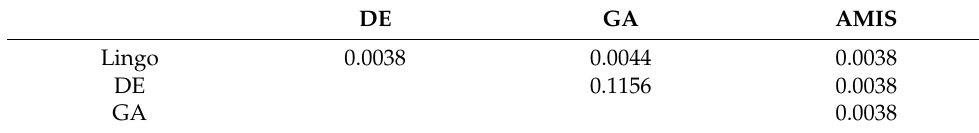
Table 18. Statistical test using the Wilcoxon signed-rank test on the results in Table 17.